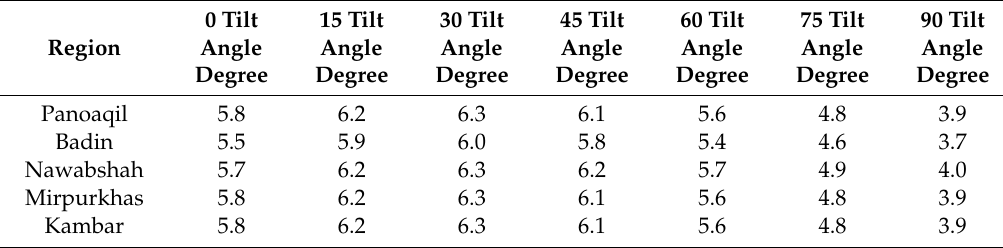
Table 4. Daily solar irradiation (kWh / m 2 / day) received on a tilted varying between 0 and 90 angle degrees. 0 Tilt Region Angle Degree